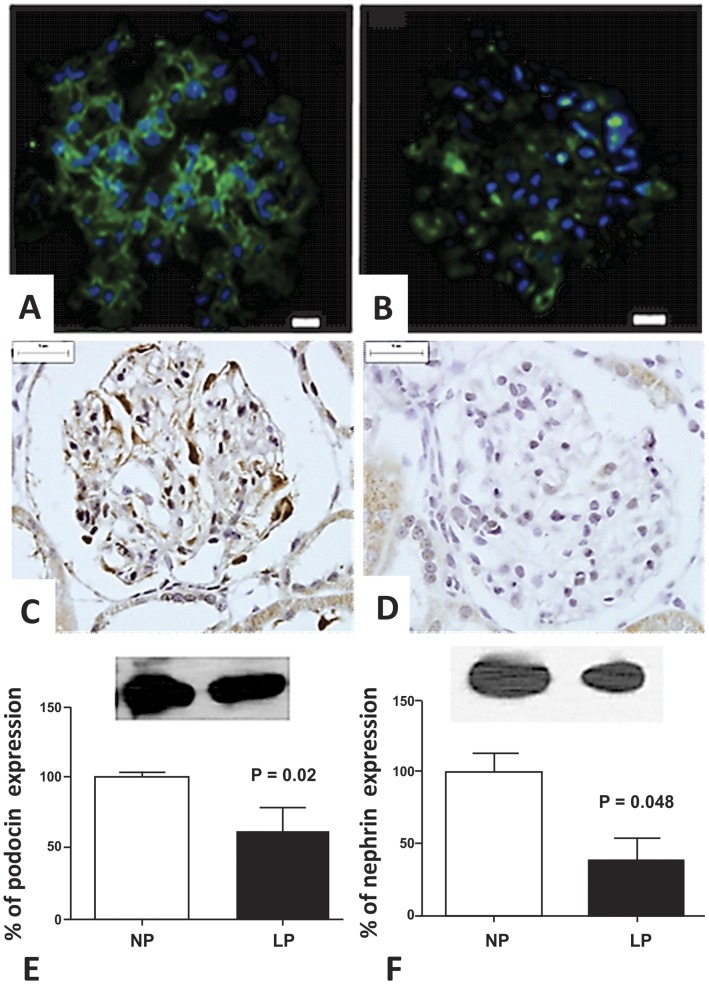
Immunohistochemistry and western blot showing reduction in the expression of glomerular epithelial markers.We can observe an extensive immunoreactivity for nephrin along NP glomerulus (from 5 rats) (A) compared to weak immunostained glomerulus in LP (from 5 rats) (B). E-cadherin glomerular expression was also reduced in LP (D) compared with NP(C) glomeruli. By western Blot from total renal tissue extract we found reduced expression of podocin (E, 39%) and nephrin (F, 62%) in LP.